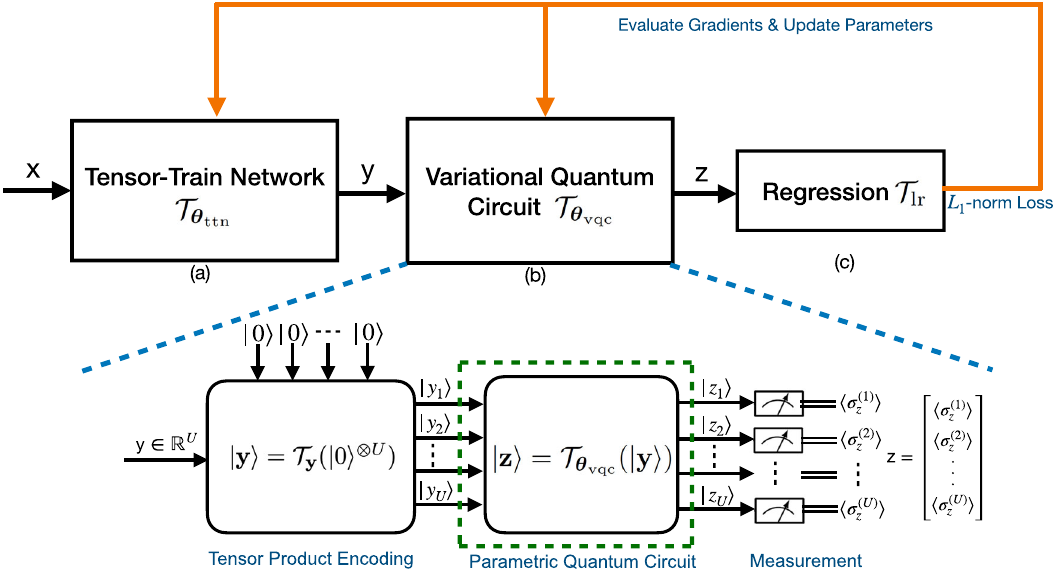
Fig. 3 An illustration of the TTN-VQC architecture. T θ and T θ represent the TTN and VQC operators with trainable parameters θ ttn and ttn vqc θ vqc , respectively. T y refers to a reversible classical-to-quantum mapping. The VQC model in the green dash square can be repeatably copied to generate a deep parametric model. The framework of functional regression outputs loss values and evaluates gradients of loss functions to update model parameters θ vqc and θ ttn . T lr refers to a fi xed regression matrix.